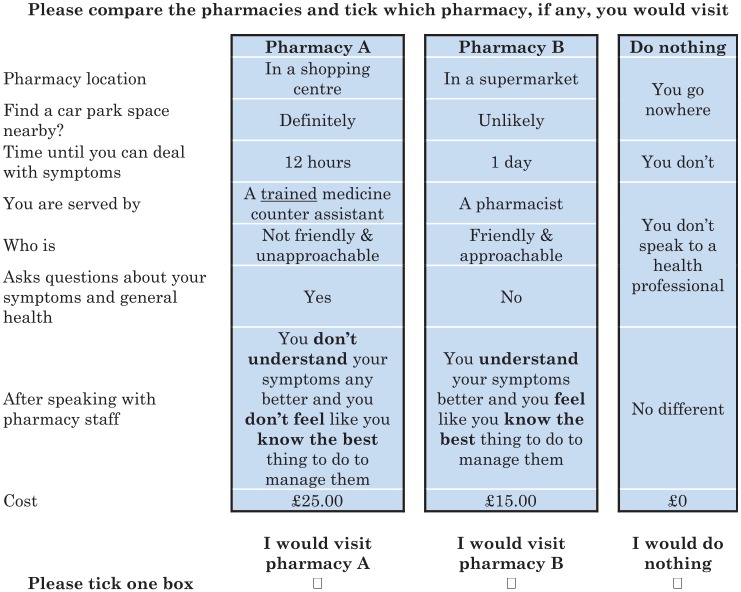
Example of choice set included in the choice experiment.